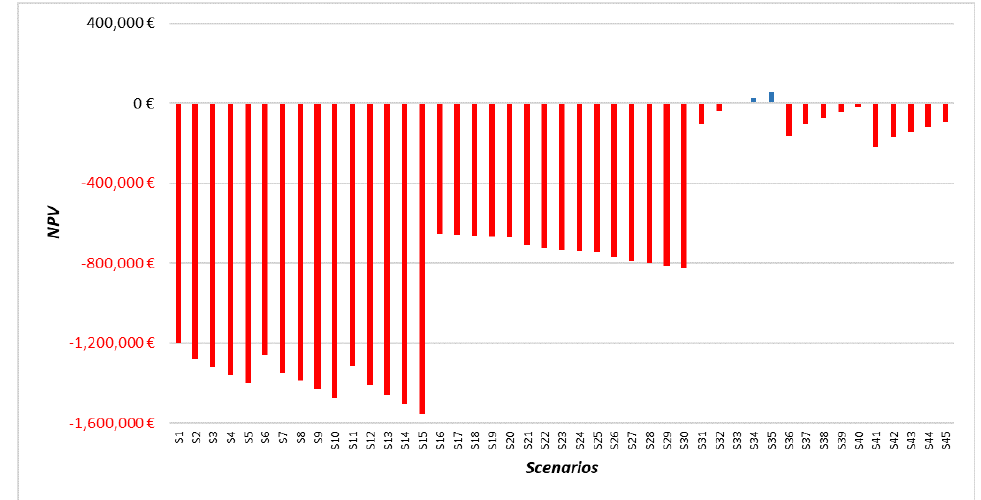
Figure 8. NPV of the thermal recycler based on various scenarios. The three parameters that affect the NPVs are the selling price of the recycled CF, the transportation and the volume of waste. The NPV is positive when the CF selling price is at a maximum, the transportation is at a minimum and the plant is saturated at least by